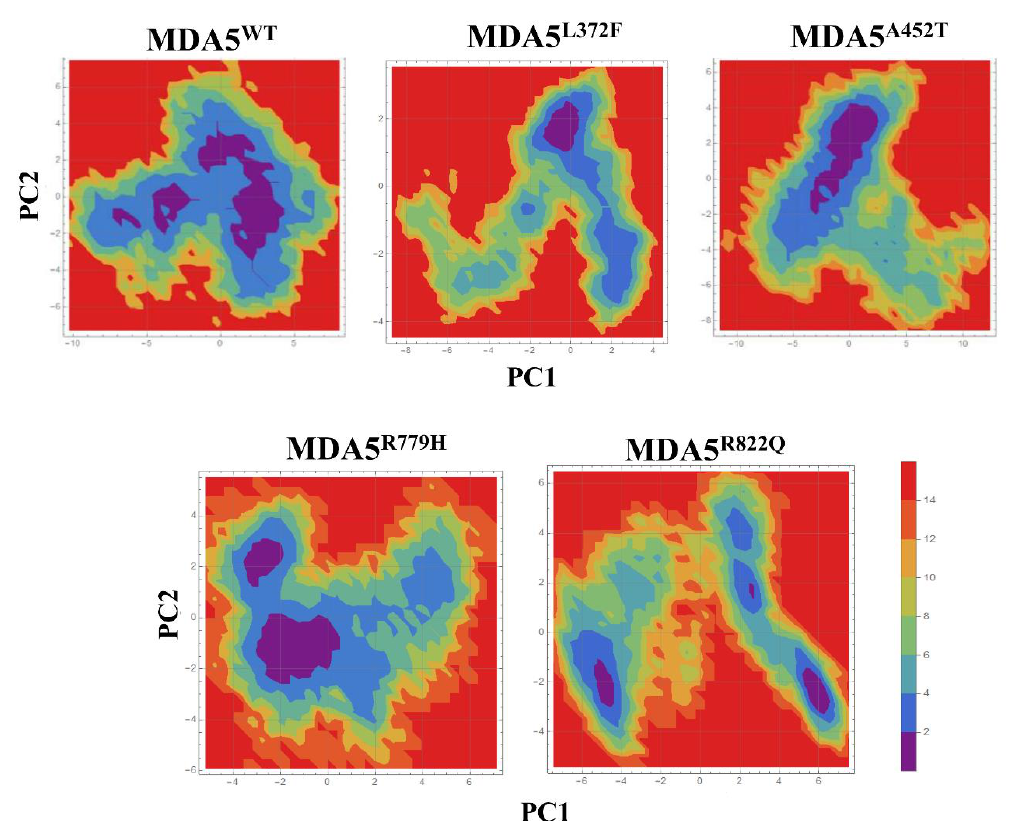
Figure 5. Free energy landscape analysis using PC1 and PC2 coordinates of the molecular dynamics trajectories of all complexes .